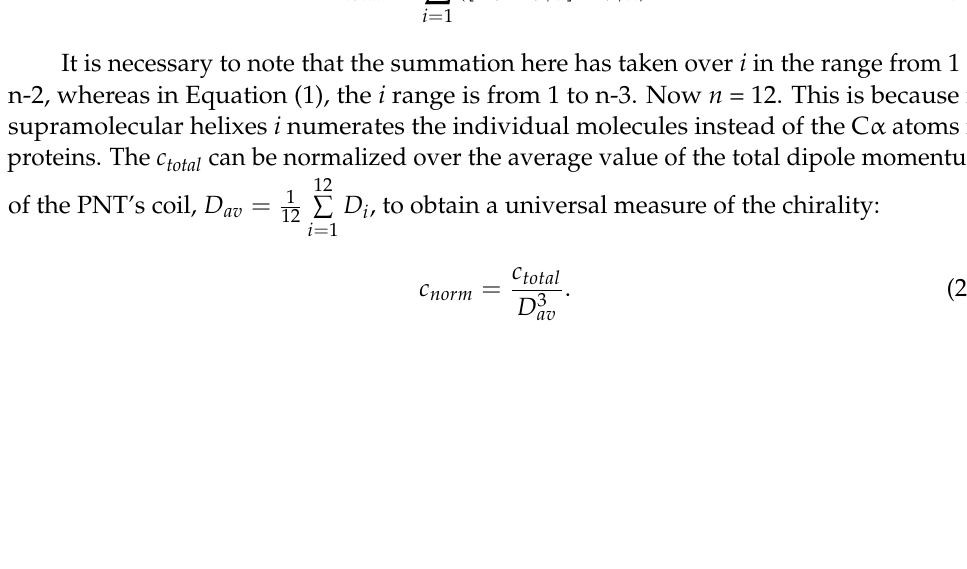
Figure 9. Schematic of the selection procedure of each consequential phenylalanine F molecule (from 1 up 12) from one corresponding coil of helix and the calculation of its dipole moment D i (for i = 1, …, 12) (in Z-projections): ( a , b )–for the L-F PNT; ( c , d )–for the D-F PNT, correspondingly.